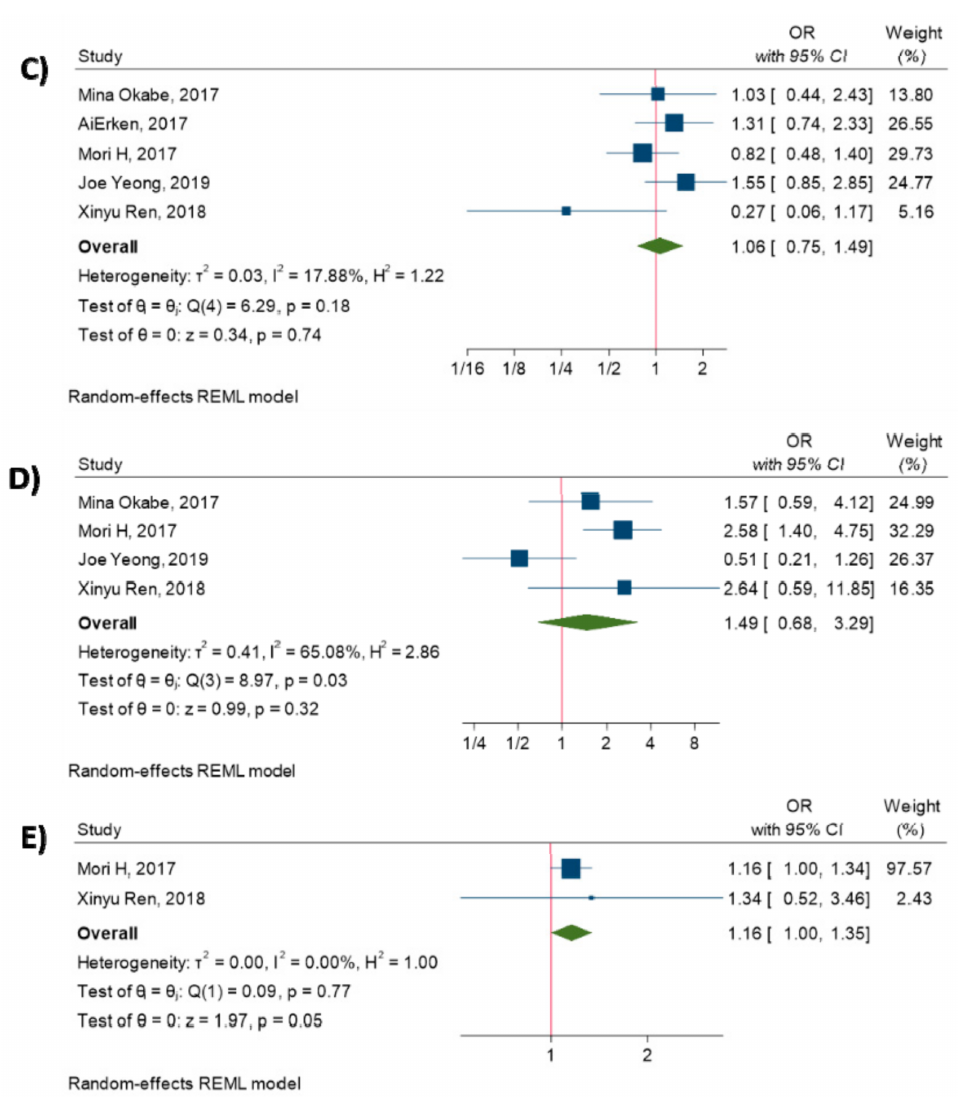
Figure 2. Forest plot of the individual odds ratio for the relation between PD-L1 expression and clinicopathological characteristics. ( A ) tumor size, ( B ) tumor stage, ( C ) lymph node metastasis, ( D ) histological grade, ( E )